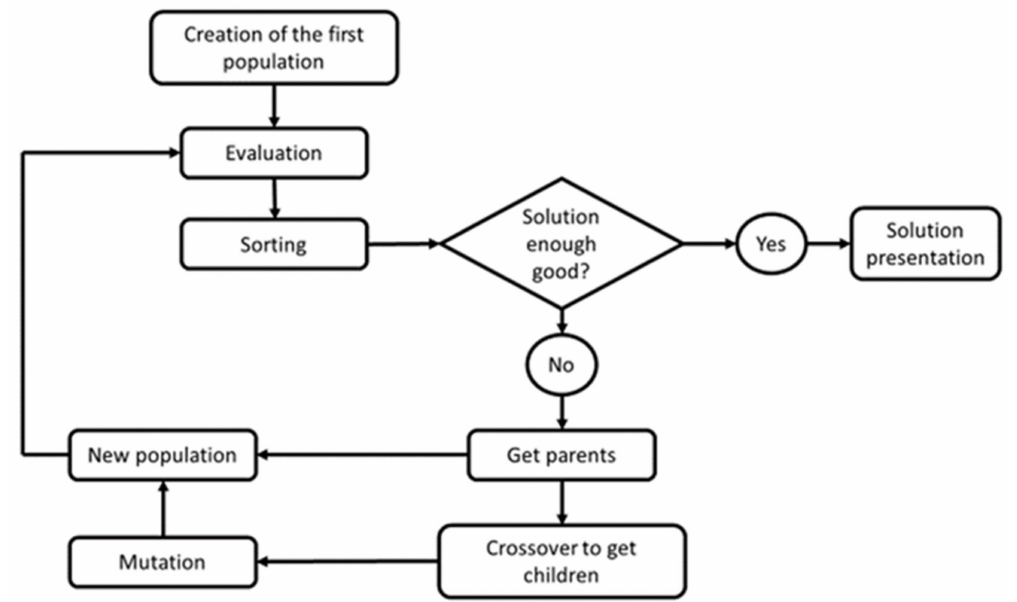
Figure 22. Genetic algorithm model flow chart.